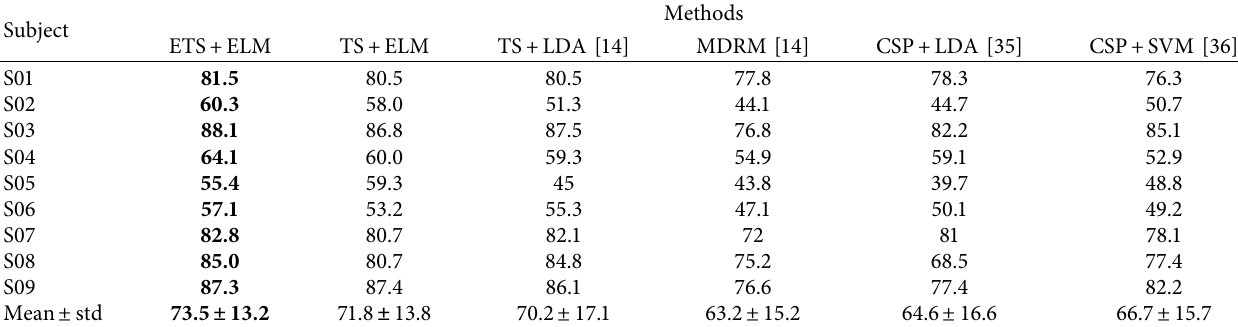
Table 2: Classification accuracy of BCI competition 2008 IIa in 30-fold cross-validation